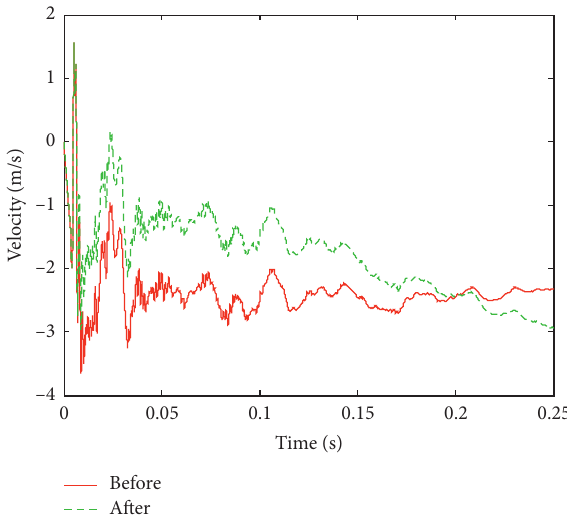
Figure 11: Comparison of velocity signals before and after rigid body motion correction.